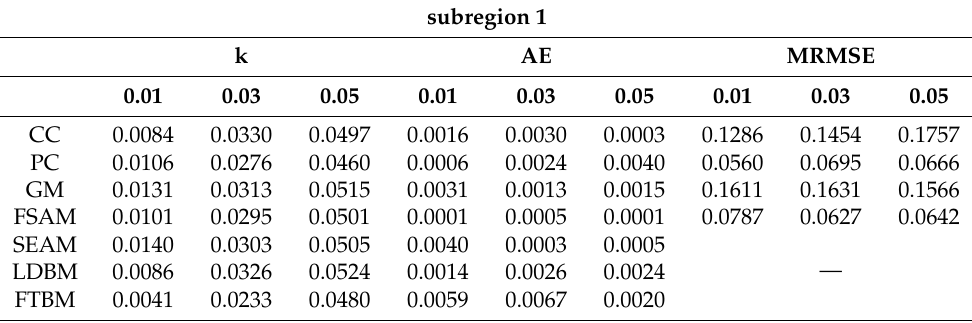
Table 3. The results of all test methods on subregion 1, subregion 2, and subregion 3 with spatial resolution of 2